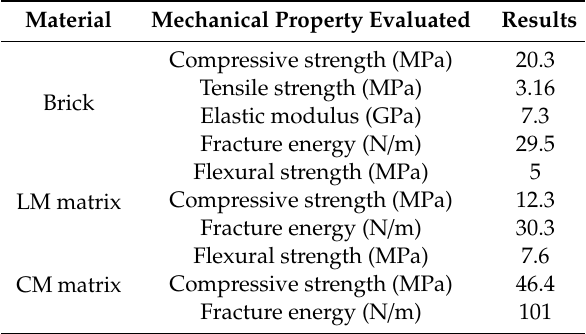
Table 2. Mechanical properties of bricks, lime-based mortar (LM) matrix, and cement-based mortar (CM) matrix.